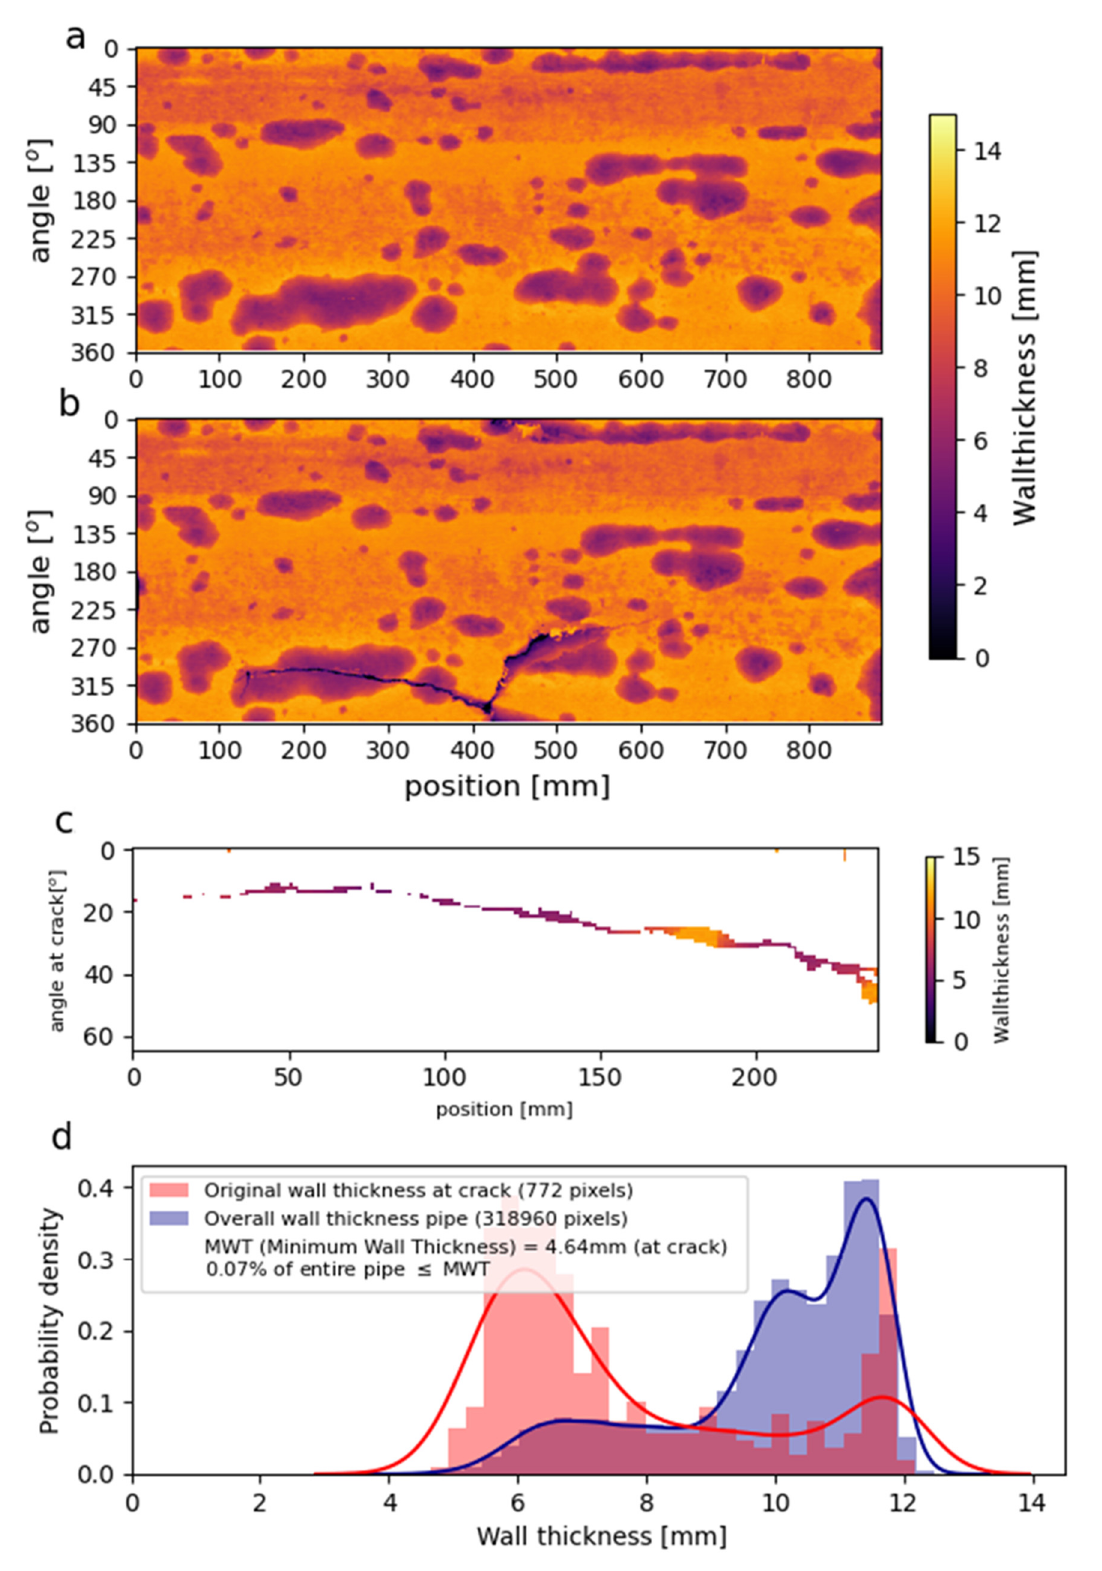
Figure 3. Approach for investigating an influence of local degradation on cracking. ( a ) The CT scan of pipe 177598 prior to the strength test; ( b ) The CT scan of the cracked pipe after the strength tests; ( c ) The remaining wall thicknesses in the first scan on the location of the crack in the second scan; ( d ) Normalized histograms of the distribution of wall thicknesses along the crack (red) and across the whole pipe (blue).